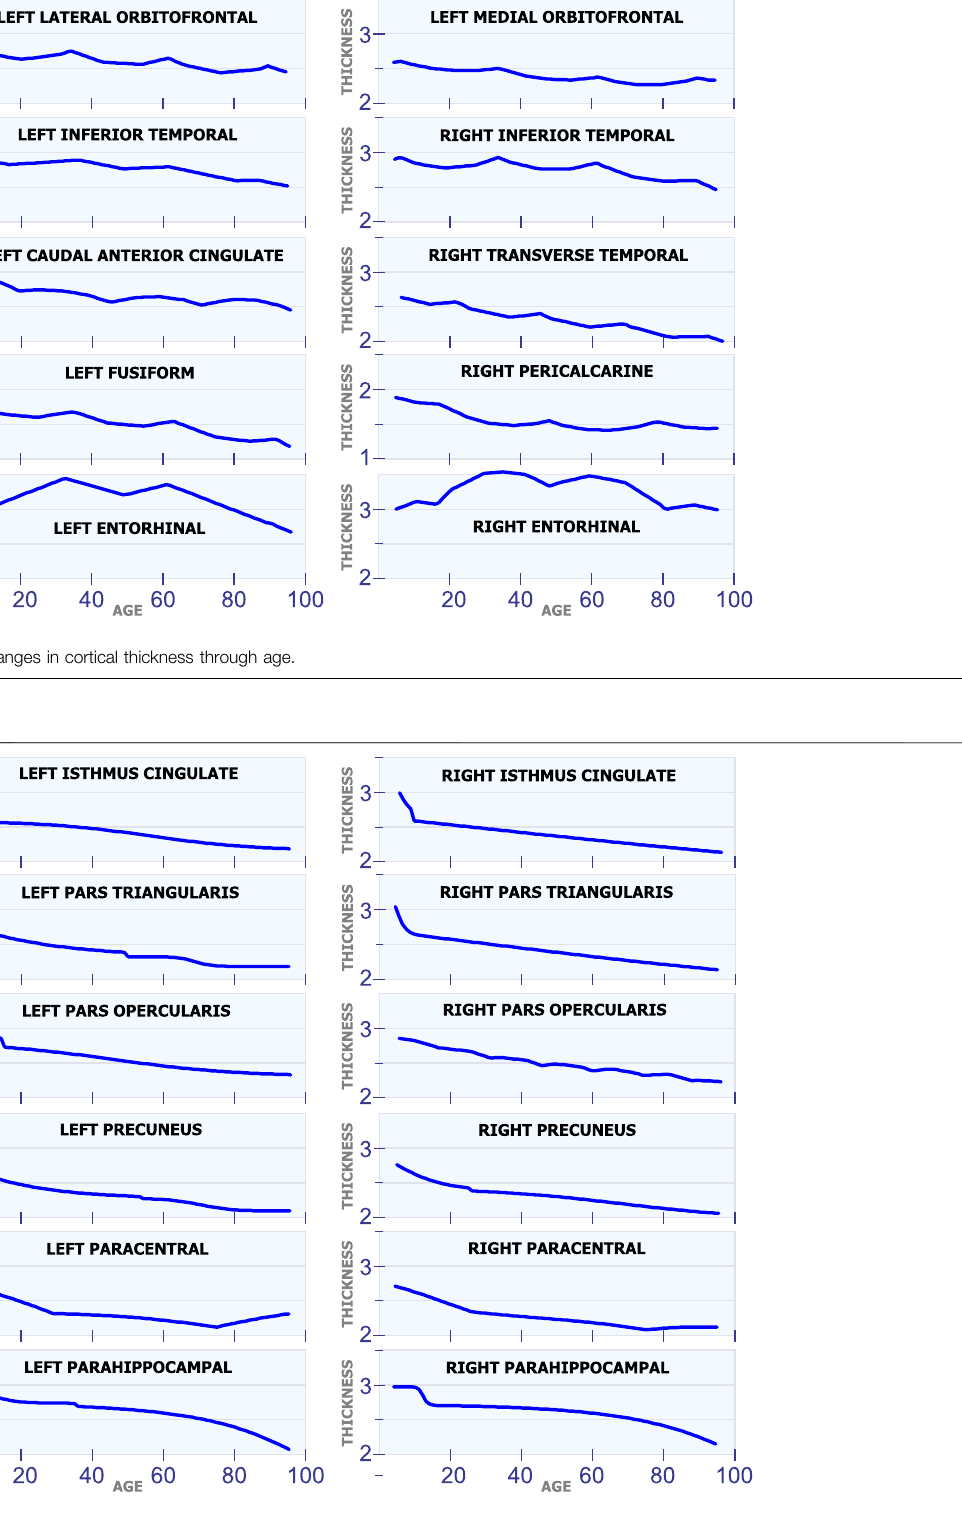
FIGURE 7 | Regions with constant changes in cortical